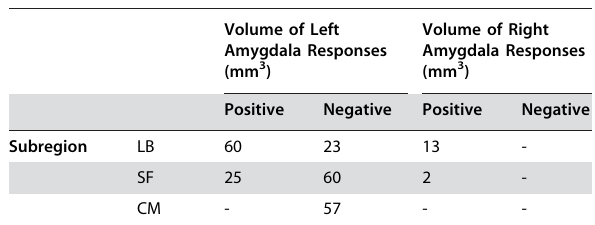
Volumes with significant effects (in mm 3 ) for the right and left amygdala presented separately for positive and negative signal changes. Results are given for the mean effect across all four music conditions (‘Mean’). LB: laterobasal group, SF: superficial group, CM: centromedial